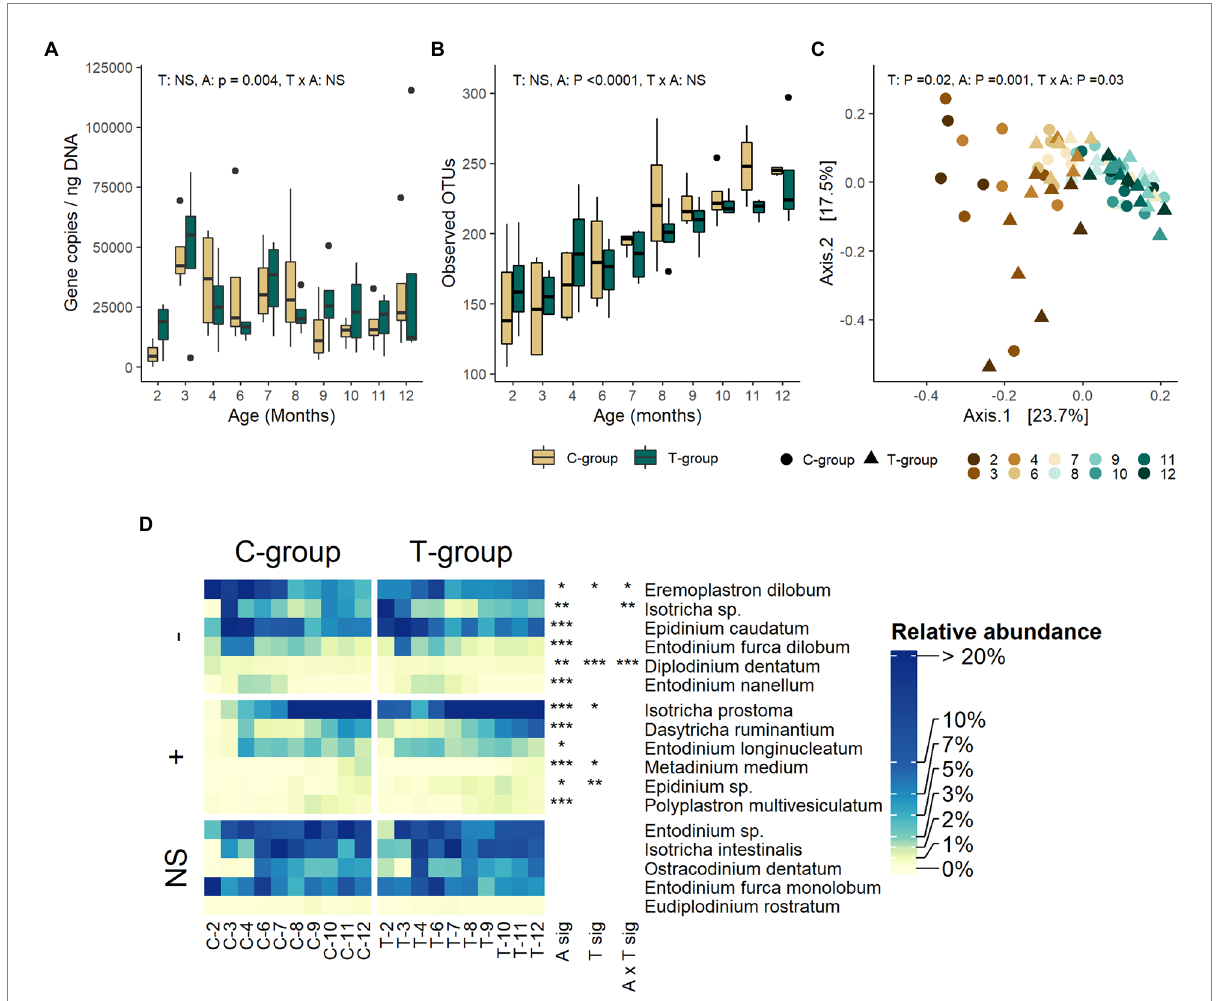
FIGURE 3 The rumen ciliate protozoa community in treatment (T-group) and control (C-group) heifers at 2–12 months of age. (A) The rumen protozoa 18S rRNA gene copy numbers, (B) the number of observed OTUs, (C) Principal coordinate analysis visualization of Bray-Curtis community distances, and (D) the relative abundances of protozoa species. Only taxa with statistical significances are shown. The taxa are grouped by increasing (+) or decreasing ( − ) trend with time, and no significant effects (NS). Statistical significance of Treatment (T-sig), Age (A-sig), and Treatment × Age interaction (T × A sig): p < 0.05: *, p < 0.01: **, p < 0.001: